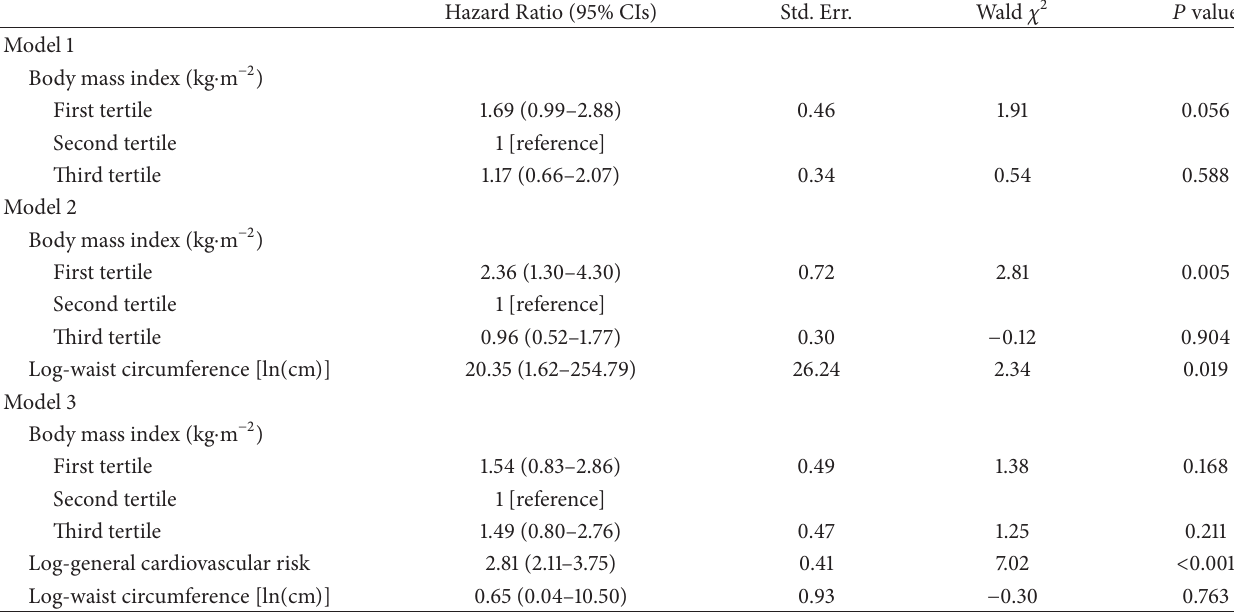
Table 2: Contribution of different tertiles of the body mass index to all-cause